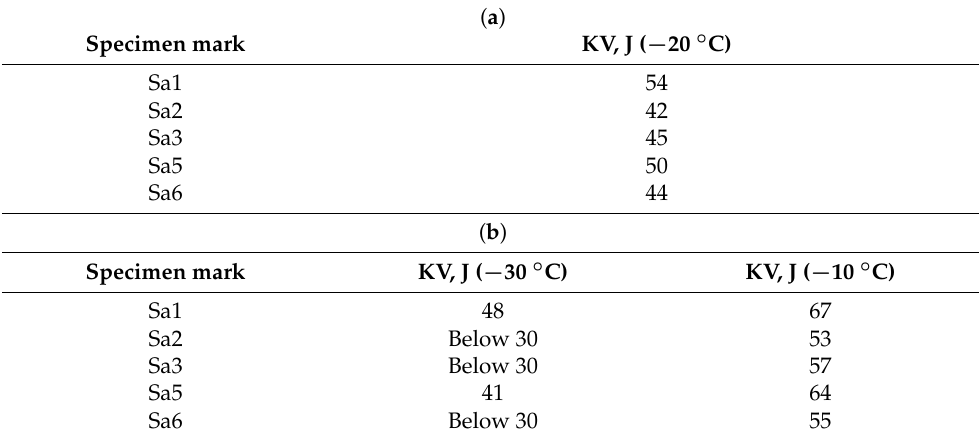
Table 5. ( a ) The results of the Charpy-V impact test obtained at a temperature equal to − 20 ◦ C. ( b ) The results from the Charpy impact test, collected at temperatures between − 10 ◦ C and − 30 ◦